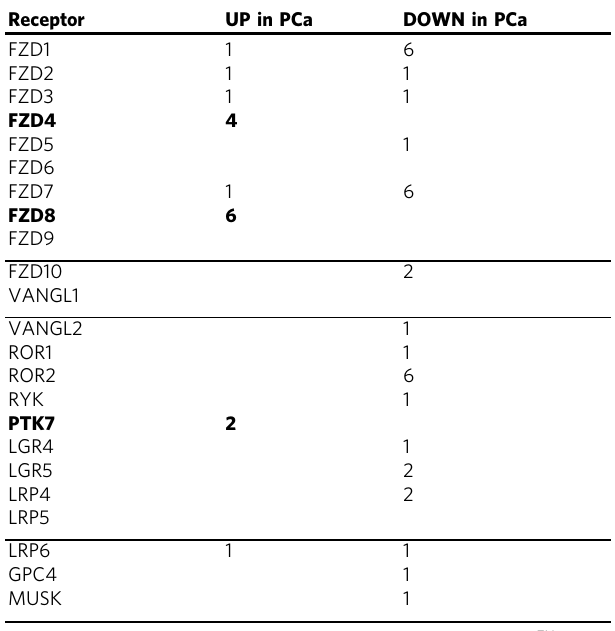
Table 2 Wnt receptor expression in prostate cancer cell lines Receptor UP in PCa DOWN in